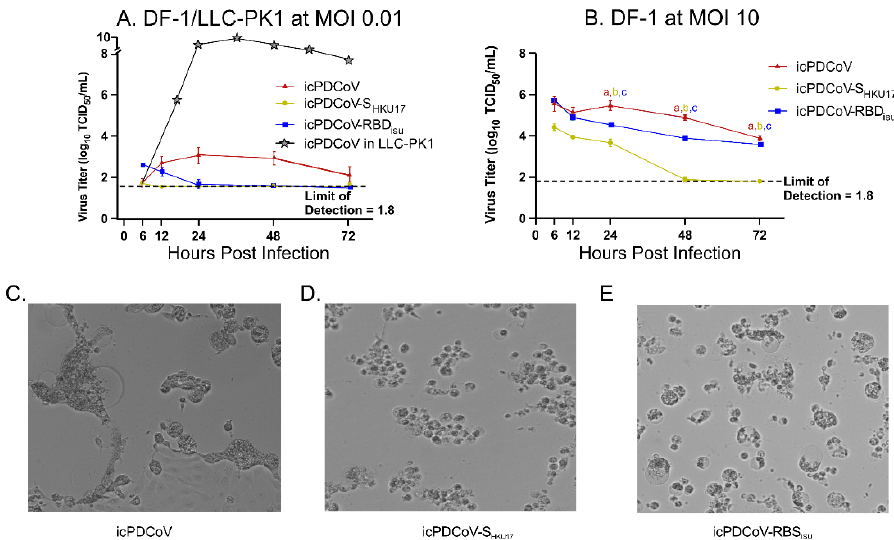
Figure 4. Replication kinetics of icPDCoV, icPDCoV-S HKU17 , and icPDCoV-RBD ISU viruses. (A) LLC- PK1 and DF-1 cell lines were inoculated at an MOI of 0.01 (4A) and DF-1 cells at an MOI of 10 (4B), respectively. LLC-PK1 kinetics at 0.01 MOI was reported previously by Niu et al. [31]. The data for icPDCoV were included in 4A as a TCID 50 kinetics reference. After 1 h of incubation at 37 °C,